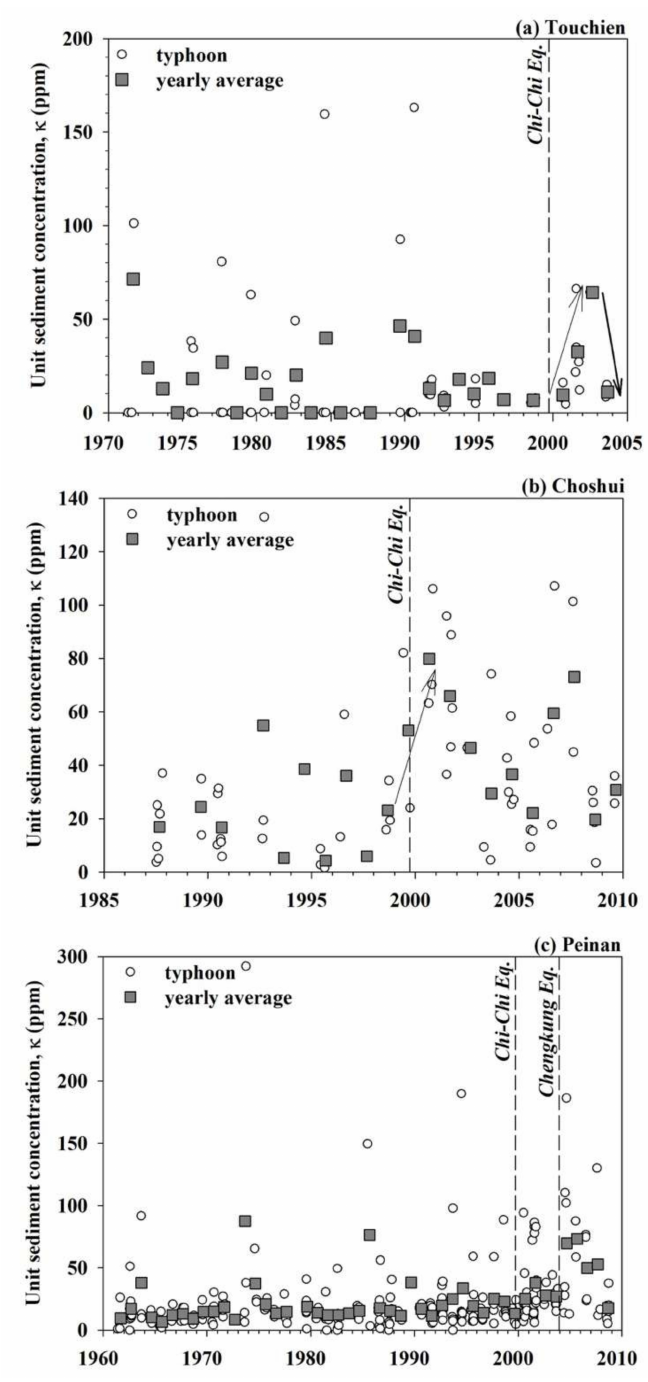
Figure 6. Time series of unit sediment concentrations in ( a ) Touchien River, ( b ) Choshui River, and ( c ) Peinan